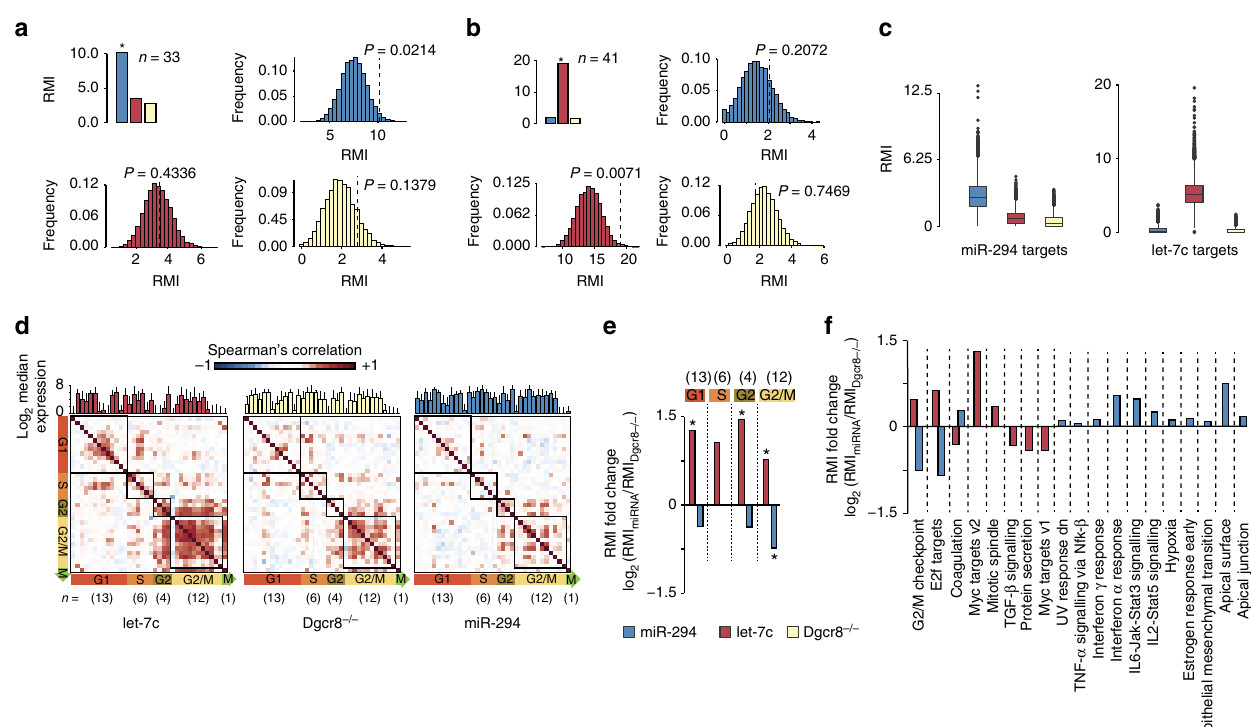
Figure 4 | Gene co-expression across cells in Dgcr8 (cid:2) / (cid:2) and Dgcr8 (cid:2) / (cid:2) transfected with either miR294 or let7c. ( a ) RMI for a set 33 of high- confidence miR294 targets in miR294-transfected (blue), let-7c-transfected (red) and Dgcr8 (cid:2) / (cid:2) cells (yellow). Histograms show permutation test for random sets of genes expressed at the same levels as the targets under each condition. Green dotted line represents RMI of the targets themselves with associated p-values. ( b ) Same as a , except for a set of 41 high-confidence let-7c targets. ( c ) RMI distribution for each of the three conditions using larger sets of miRNA targets (defined as down with addition of miRNA and predicted by Targetscan, miRanda-miRSVR or previous population array data). As power of RMI is reduced by the larger size of these target sets, a distribution of RMIs was computed by randomly extracting a subset of 10 genes with replacement 10,000 times from the corresponding list of targets. ( d ) Spearman’s correlations among 36 cell cycle-regulated transcripts in miRNAs transfected and Dgcr8 (cid:2) / (cid:2) cells show an increase of cell cycle-dependent transcription in let-7c-transfected cells. Genes are grouped by cell cycle phases (squares) and ordered in the same way across conditions. Above each heatmap the average expression of each gene and its standard deviation is reported. ( e ) Differential RMI among 36 cell cycle-regulated transcripts (Supplementary Data set 7) in miRNAs transfected versus Dgcr8 (cid:2) / (cid:2) cells show an increase of cell-cycle-dependent transcription in let-7c transfected cells. Genes are grouped by cell cycle phases and their RMI value was compared in miRNA transfected cells versus Dgcr8 (cid:2) / (cid:2) cells. The number of genes used for each cell cycle phase is reported in the upper part of the plot. Significant changes of RMI determined by permutation test are indicated with asterisks (let-7c G1/S P ¼ 0.026, G2 P ¼ 0.04, G2/M P ¼ 3 e (cid:2) 3; miR-294 G2/M P ¼ 0.016). ( f ) Differential RMI among hallmark gene sets from MSigDb in miRNAs transfected versus Dgcr8 (cid:2) / (cid:2) cells. For each hallmark gene set we computed RMI across the three conditions (miR-294, let-7c and Dgcr8 (cid:2) / (cid:2) ) and then computed the RMI fold-change (miR-294 versus Dgcr8 (cid:2) / (cid:2) and let-7c versus Dgcr8 (cid:2) / (cid:2) ) and its significance determined by permutation test. Only genes set with significant changes are